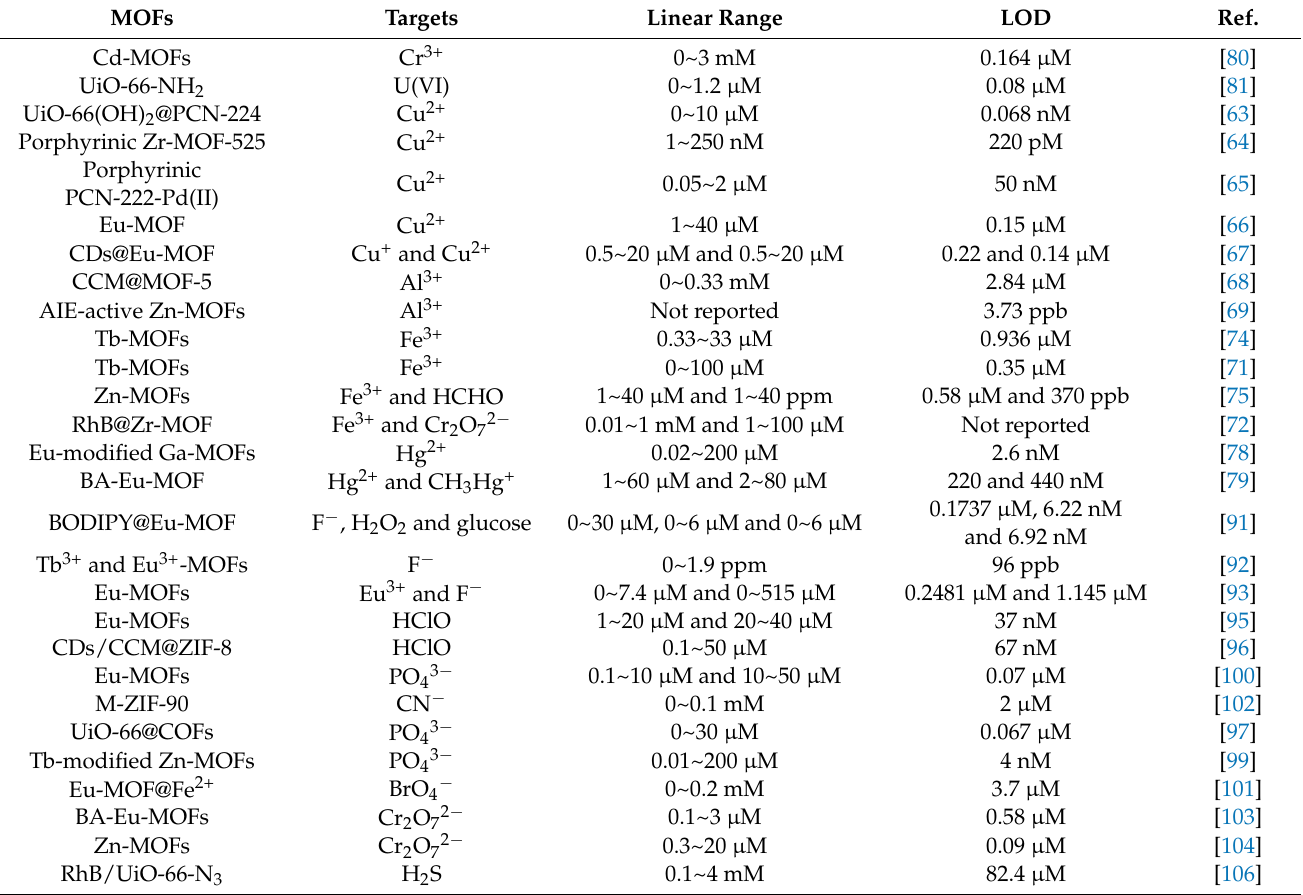
Table 1. Performances of MOFs-based fluorescent chemosensors for the detection of inorganic ions. Targets Linear Range LOD